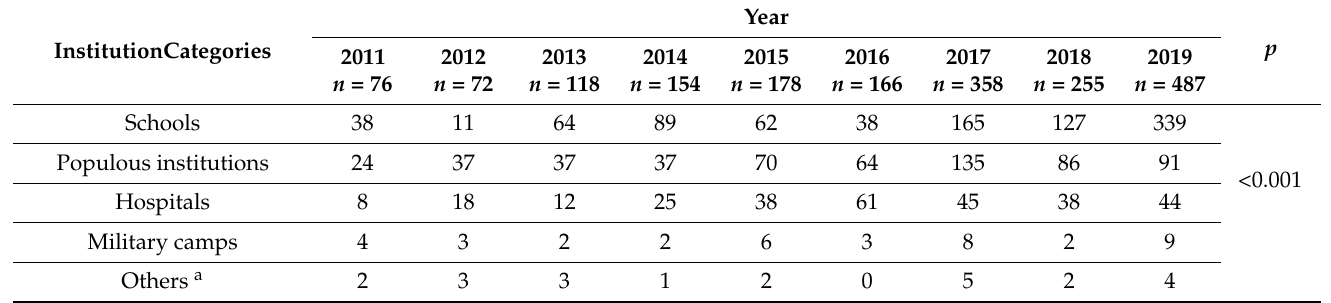
Table 4. The risk factors of institutions from analyzed URTI cluster data from 2011 to 2019,